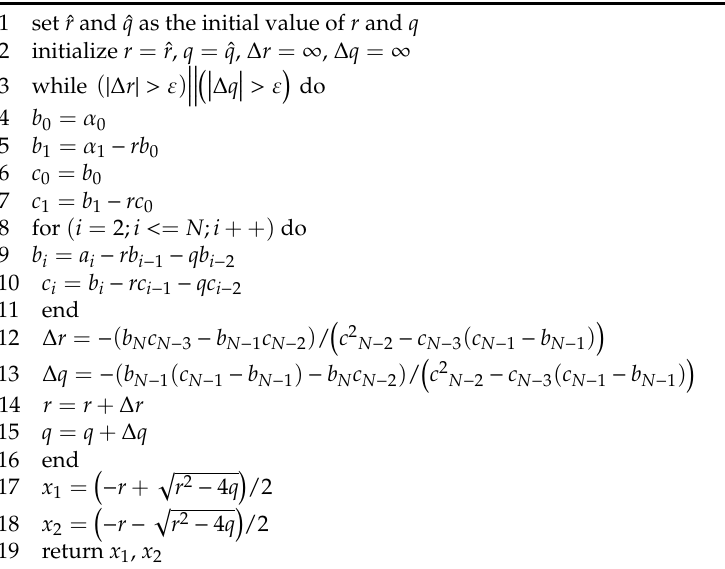
Table 1. Pseudocode of the proposed